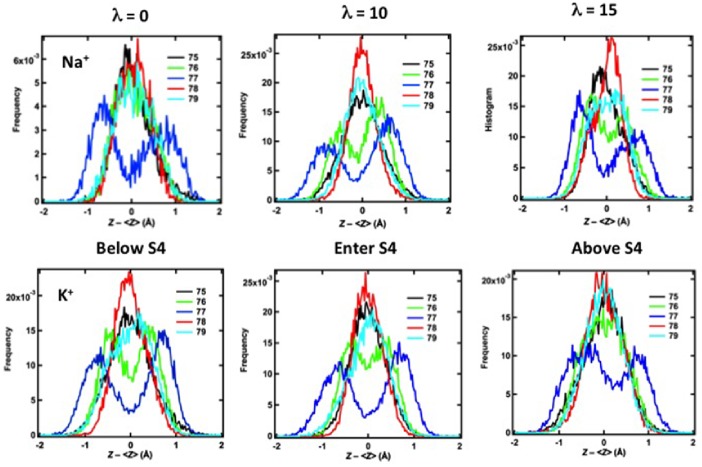
Positions of carbonyl oxygen atoms for amino acids T75–G79 in the KcsA selectivity filter during step-wise pulling of either Na+ (top row) or K+ (bottom row) from the vestibule toward the extracellular surface of the membrane.The y-axis is the frequency (probability) of finding the oxygen atoms at the position shown on the x-axis. Zero in the middle of the x-axis corresponds to the position of the atoms observed in the crystal structure. The carbonyl atoms corresponding to each amino acid in the tetrameric selectivity filter are shown in a single color, and each amino acid is represented by a different color (T75, black; V76, green; G77, blue; Y78, red; G79, light blue).